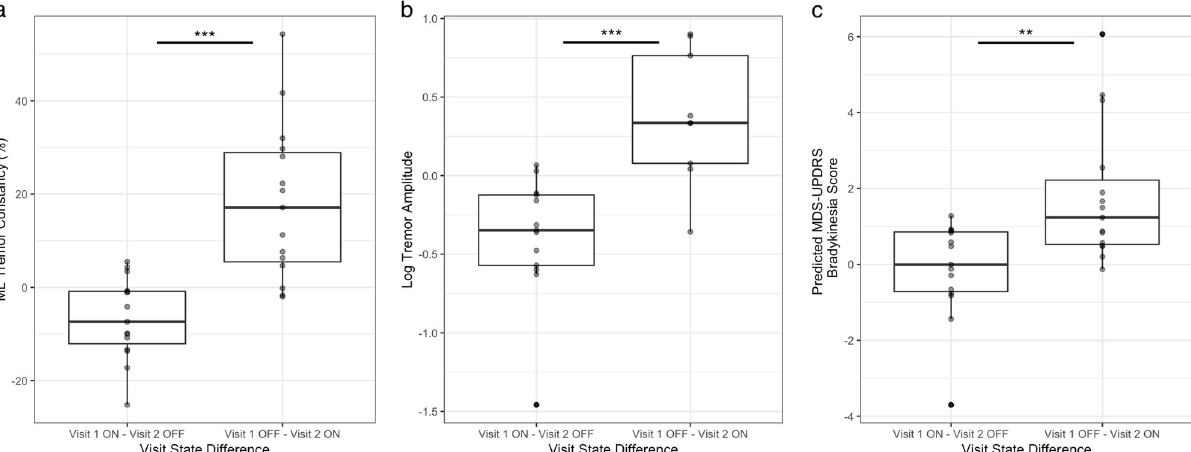
Fig. 5 Motor state associated changes in sensor-based assessment of resting tremor and hand bradykinesia. Distribution of difference between ON and OFF states of sensor-derived measures of a tremor constancy, b tremor amplitude, and c predicted hand bradykinesia score grouped by the randomized order of motor state in visit 1. Box plot center line, median; box limits, upper and lower quartiles; whiskers, 1.5× interquartile range; points, outliers; ** p < 0.01, *** p <